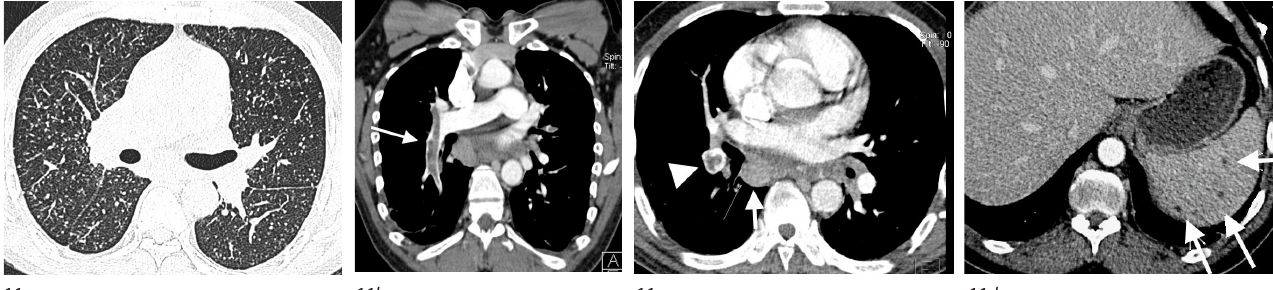
Fig. 11. Opportunistic nodular lung infection in immunocompromised patient. Unsuspected pulmonary arterial emboli noted on the right (arrow in 11b and arrowhead in 11c). Lymph node enlargement noted (arrow in 11c). Micro-abscesses also identified in spleen (arrows in 11d) at the inferior range of the